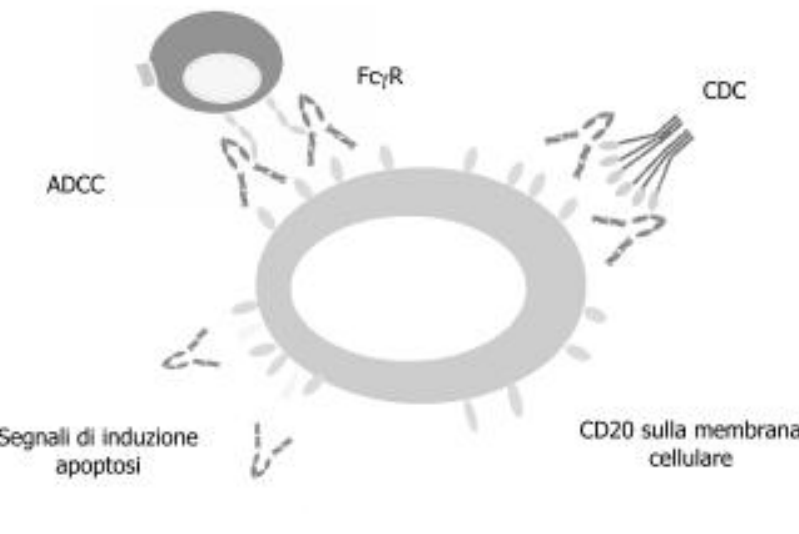
Figura 1. Meccanismo d’azione di Rituximab. Rituximab può espletare attività anti-neo- plastica attraverso meccanismi diretti ed immunomediati. Il legame all’antigene di mem- brana CD20 ha effetto di inibizione del ciclo cellulare e di induzione di apoptosi. Il legame del complemento al frammento Fc g stimola un meccanismo di lisi della cellula bersaglio (CDC: complement mediated cytotoxicity). Analogamente, il riconoscimento ed il legame del frammento Fc g da parte di specifici recettori di membrana presenti sulle